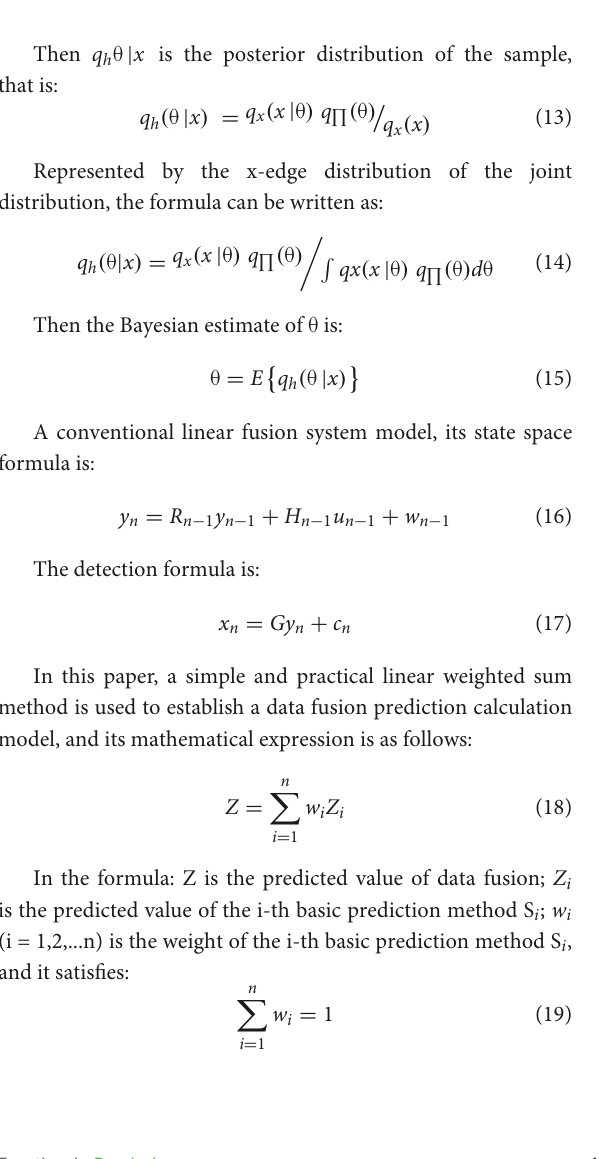
FIGURE6 Thinking path of fusion